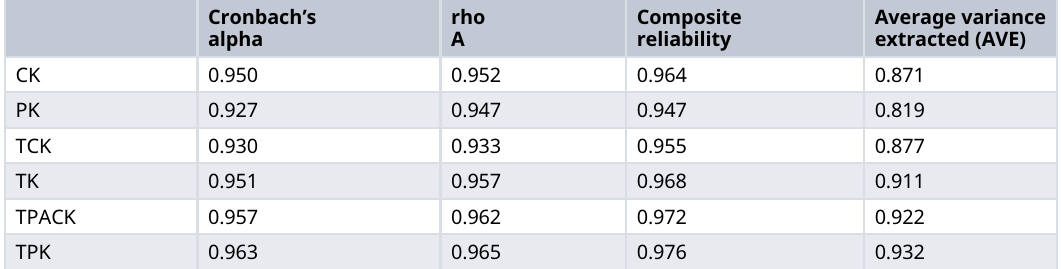
Table 2. Construct reliability and validity.